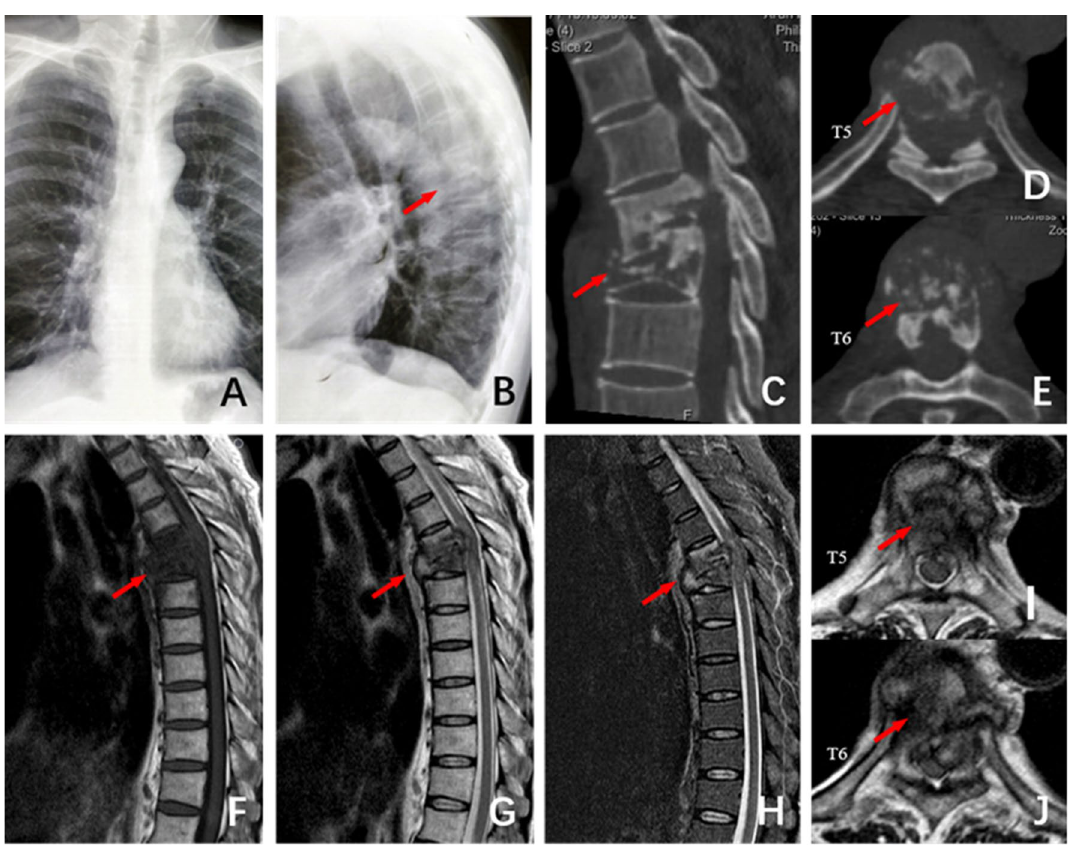
Figure 1. The patient, male, 51 years old, T5 ~ T6 spinal tuberculosis secondary to kyphosis deformity. ( A ) and ( B ) The frontal and lateral X-ray films before surgery showed vertebral destruction of T5 ~ T6 and Cobb Angle of 40°. ( C–E ) Preoperative CT showed severe damage to the anterior column of the T5 ~ T6 vertebral body and normal posterior column. ( F–J ): Preoperative MRI showed vertebral destruction of T5 ~ T6 and obvious compression of the spinal